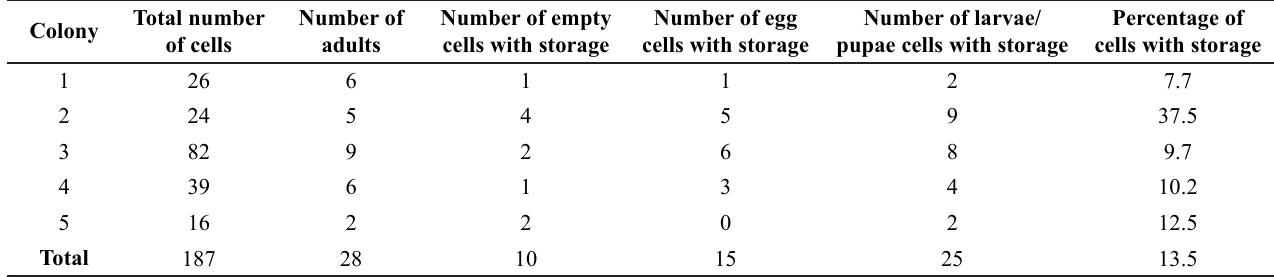
Table 1 . Composition of the five colonies of Mischocyttarus socialis found with storage of honey at the botanical garden of Universidade Federal de Juiz de Fora and the percentage of cells used for the storage. Total number Number of Number of empty Colony of cells adults cells with storage